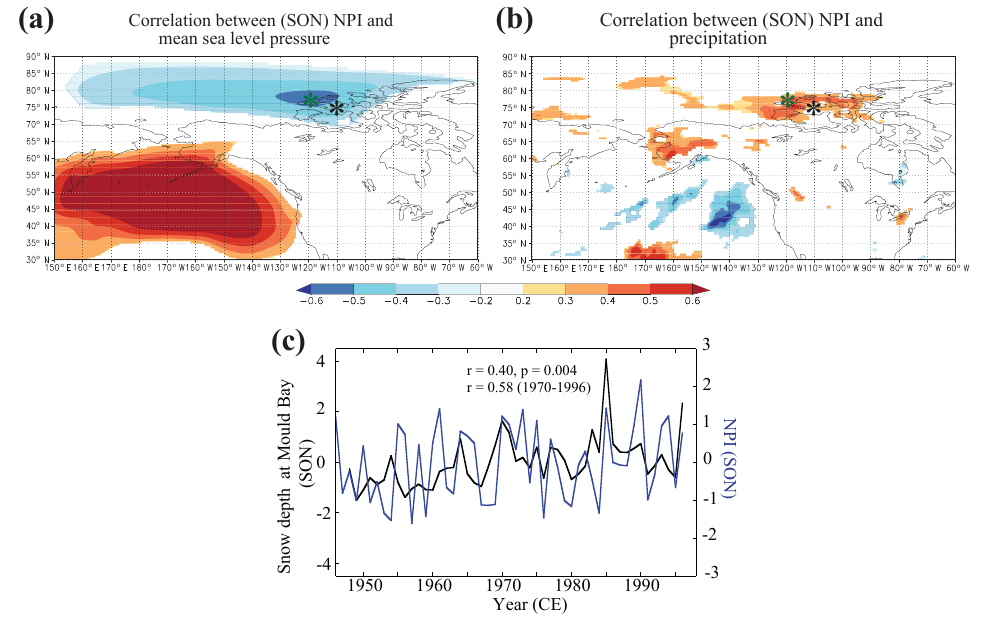
Figure 2. North Pacific Index (NPI) and precipitation during September–November. (a) Correlation between NPI (Trenberth and Hurrell, 1994) and mean sea level pressure from 1979 to 2015. (b) Same as (a) , but for precipitation anomalies (Dee et al., 2011) correlated with NPI index. Black and green asterisks denote Cape Bounty and Mould Bay weather stations respectively. (c) Comparison between the time series at Mould Bay snow depth and NPI during September–November (Trenberth and Hurrell, 1994). Note that Mould Bay weather station stopped operating in 1996CE.